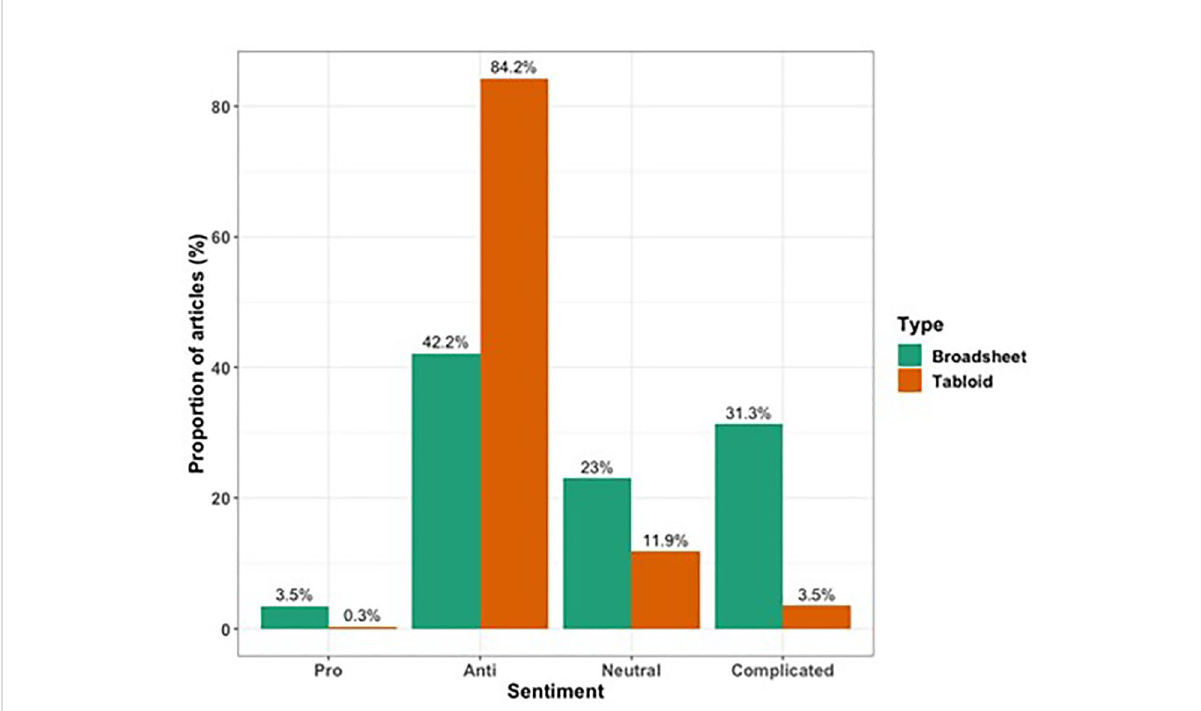
FIGURE 3 Proportions of tabloid and broadsheet articles by sentiment across all articles published between 1 July 2010 and 30 June 2020 (n =